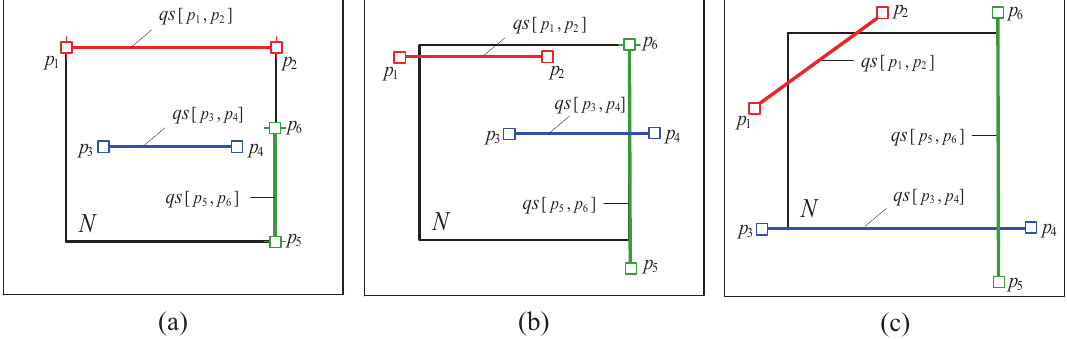
Figure 5. Simple intersection relationships between qs and N . ( a ) qs is inside N or N contains qs ; ( b ) qs partially intersects N or vice versa; ( c ) qs fully intersects N or vice